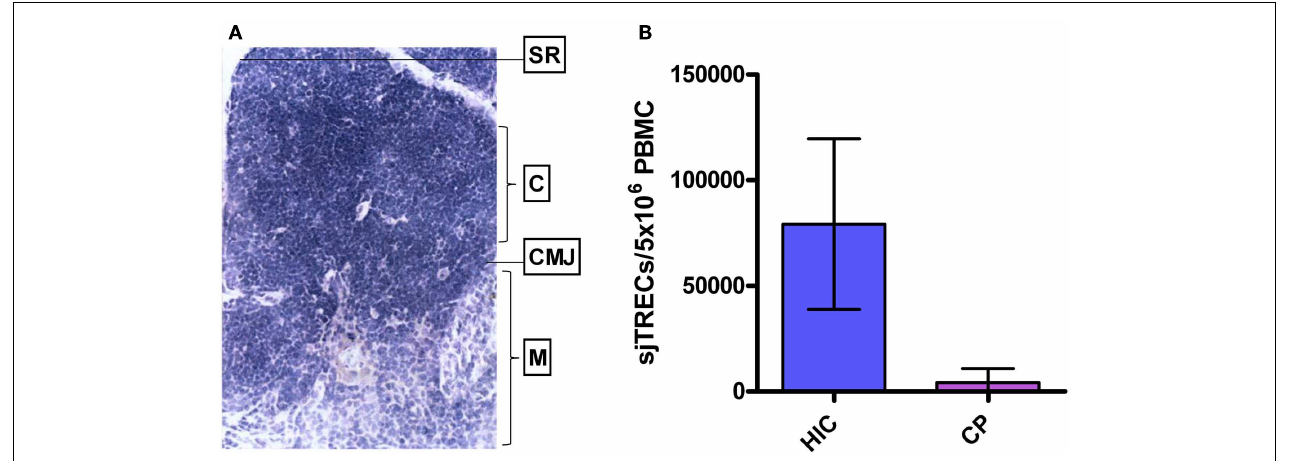
controllers (HIC; “True LTNP”) compared to age-matched HIV-1 + chronic progressors (CP). Histogram plots show median values with standard deviations. Data from Imami et al. (2001), Pido-Lopez et al. (2003), and Westrop et al.